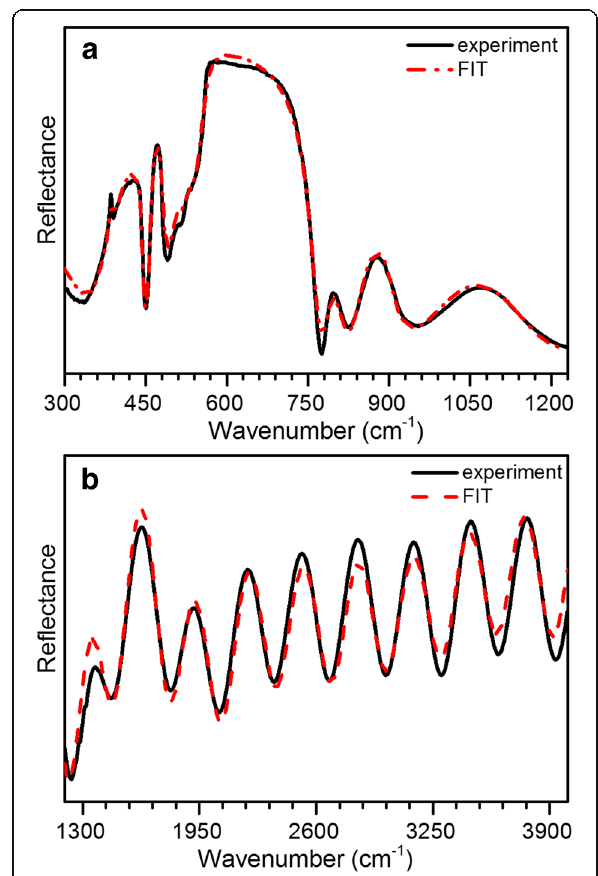
Fig. 6 Experimental ( solid line ) and best-fit calculated ( dash-dot line ) IR reflectance spectra of the n + /n 0 /n + -GaN structure grown on GaN- template/Al 2 O 3 . a Reststrahlen region. b Interference 560 cm − 1 and ω = 740 cm − 1 . The phonon frequencies for LO each layer were refined in the fitting process. Obtained best-fit parameters with the error bars are given in Table 1.